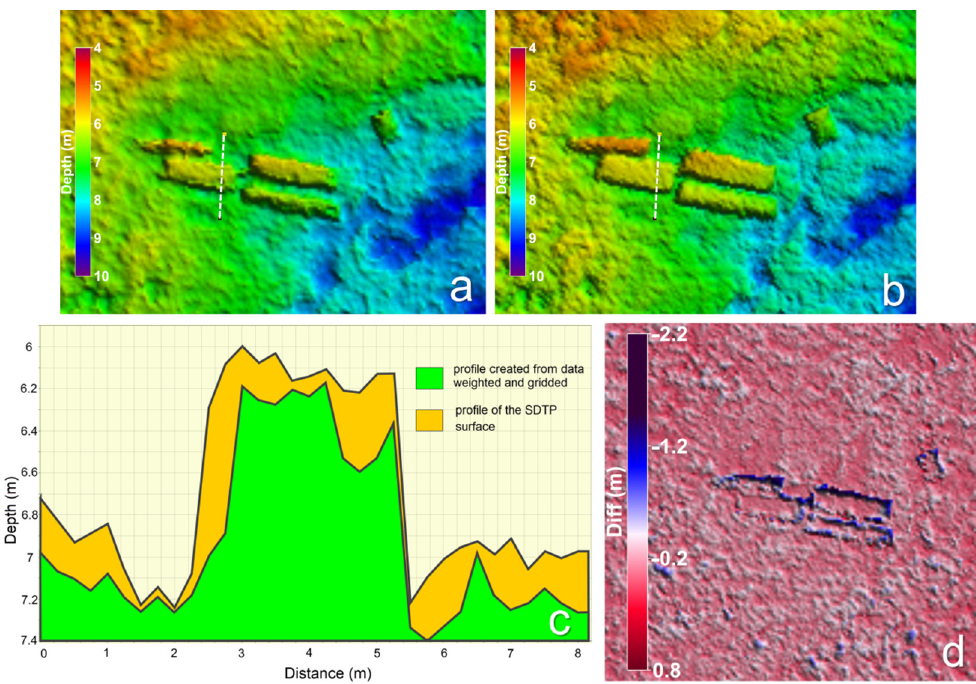
Figure 12. Comparison between wreck bathymetric models, created under different data gridding methods. ( a ) Bathymetric surface created from data weighted and gridded at 0.25 m. ( b ) Bathymetric surface displaying the shoalest soundings contributing to a node at their true position. ( c ) Comparison of profiles from a common section (white lines at ( a , b )) across the wreck. The profile of the surface created from data weighted and gridded is shown in green, while the profile of the SDTP surface is shown in orange. ( d ) A 3D surface quantifying the difference between the two surfaces.